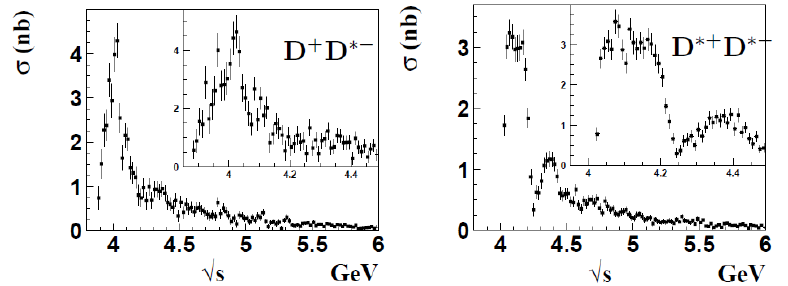
√ s for (a) e + e − → D + D ∗− (b) e + e − →